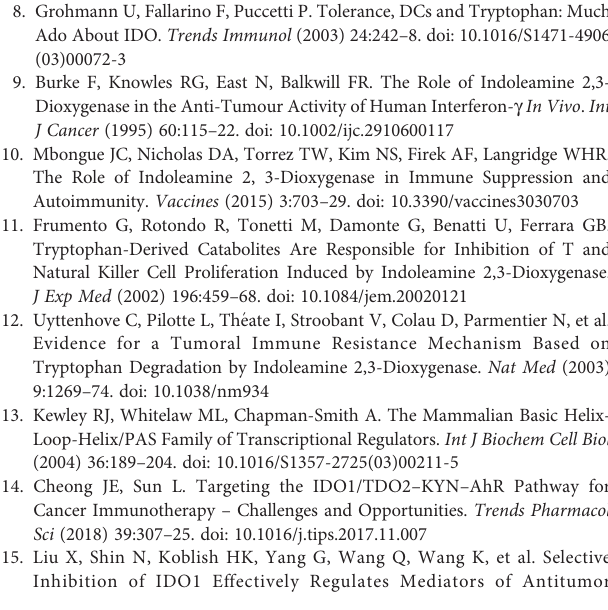
Supplementary Table 1 | List of primers used for Real Time PCR. Supplementary Table 2 | List of primary antibodies used in this